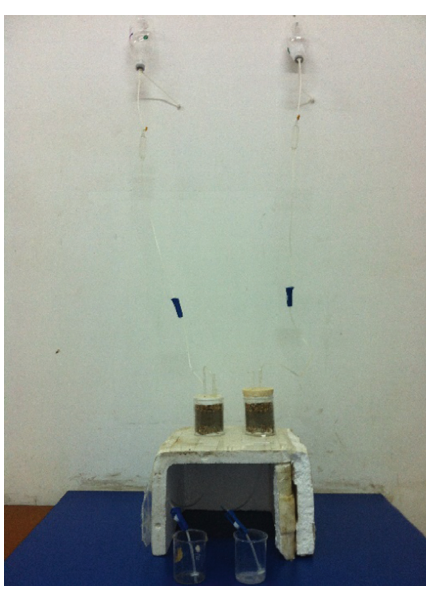
Figure 3: Sporosarcina Pasteurii strains on solid medium. Figure 2: Physical model of the MICP experimental device.